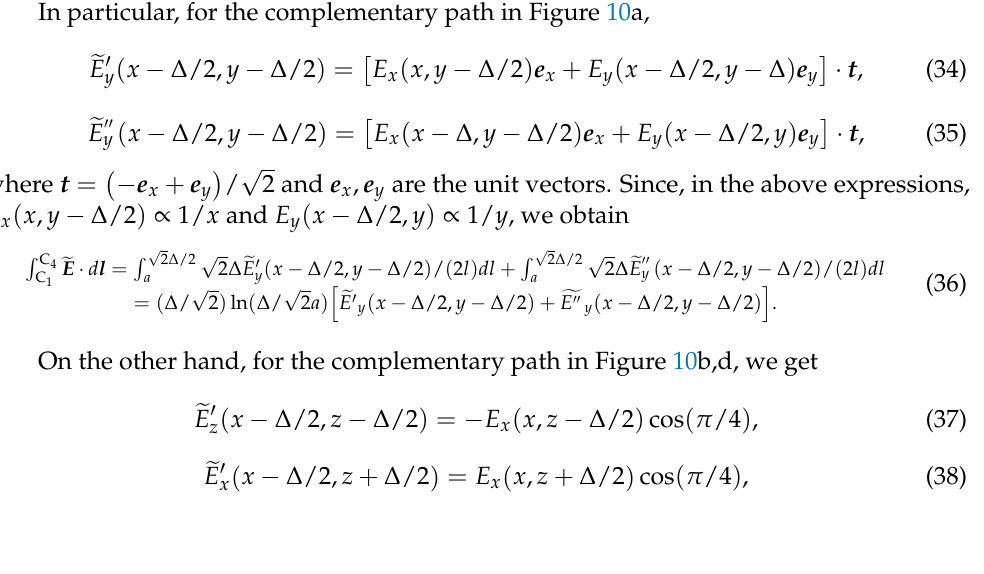
Figure 10. The proposed PI model for a thin wire antenna of radius a . Integral path ( a ) in the vicinity of the wire at a xy cross section, ( b ) for a wire end on the z axis, ( c ) in the vicinity of the wire along the z axis (this part uses only the basic path), and ( d ) for the feed point with a ∆ gap on the z axis. The black solid line signifies the basic path and dashed blue line the modified complementary path, while, for simplicity, the y axis, in ( b – d ), and the z axis, in ( a ), are omitted. Designating as S B the area enclosed by the basic path and S C the area enclosed by the complementary path, the integral area (cid:82) H · d S is: S B = ∆ 2 − π a 2 /4 and S C =2 ∆ 2 − π a 2 /2 for ( a ); S B = ∆ 2 and S C =7 ∆ 2 /4 − a 2 /2 for ( b ); for ∂ t S S B = ∆ 2 − a ∆ for ( c ); S B = ∆ 2 and S C = 7 ∆ 2 /4 − a 2 for ( d